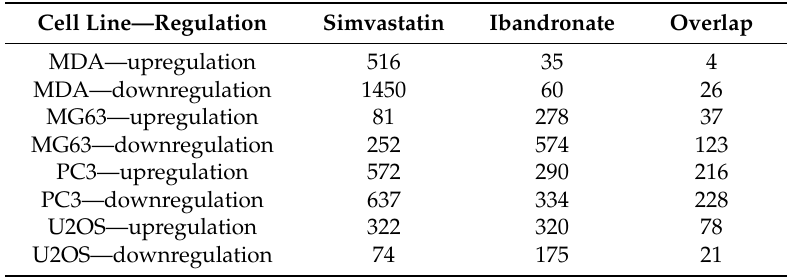
Table 6. Drug-induced gene regulation, based on evaluation of respective